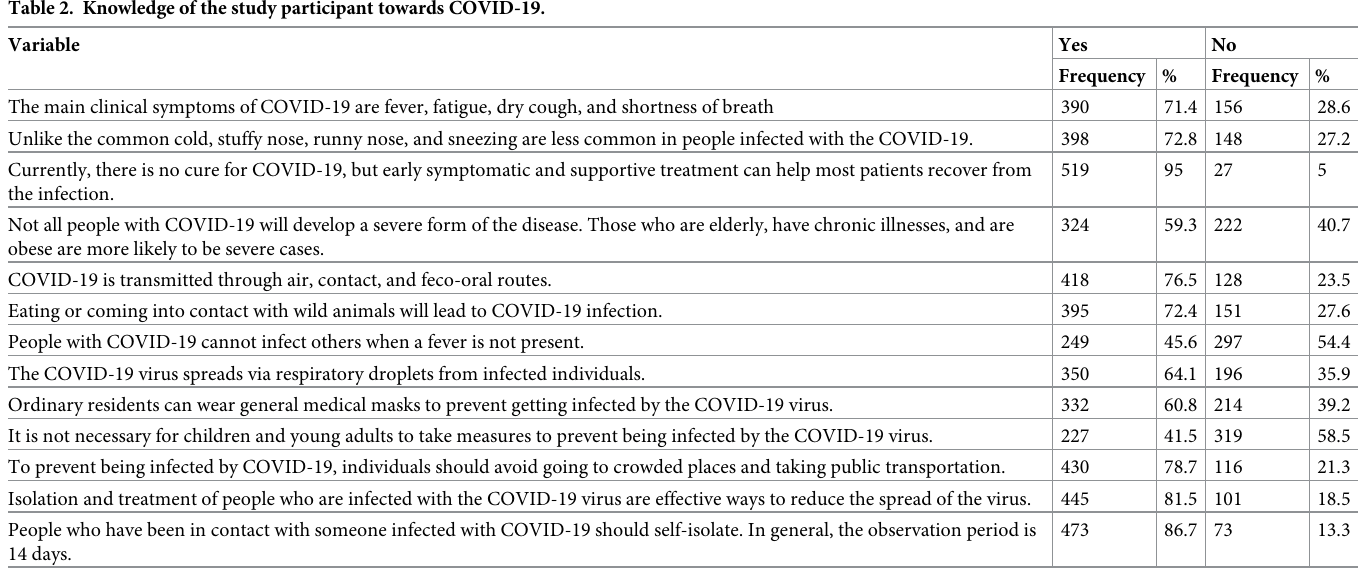
Table 2. Knowledge of the study participant towards COVID-19. Variable